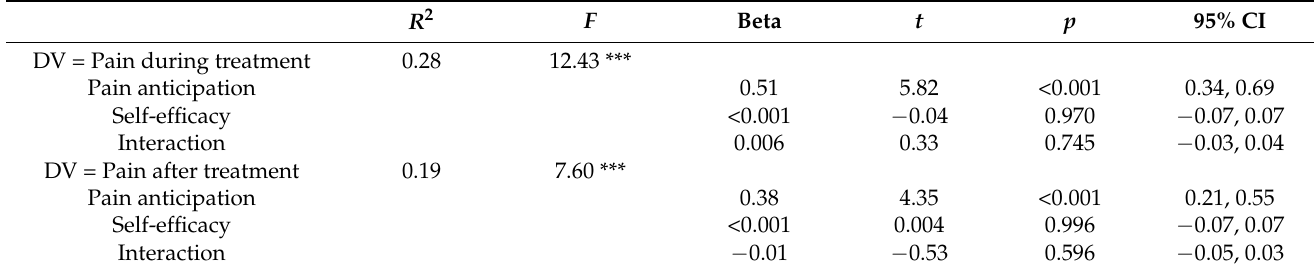
Table 2. Prospective prediction of pain during and after treatment from anticipation of pain, self- efficacy and their